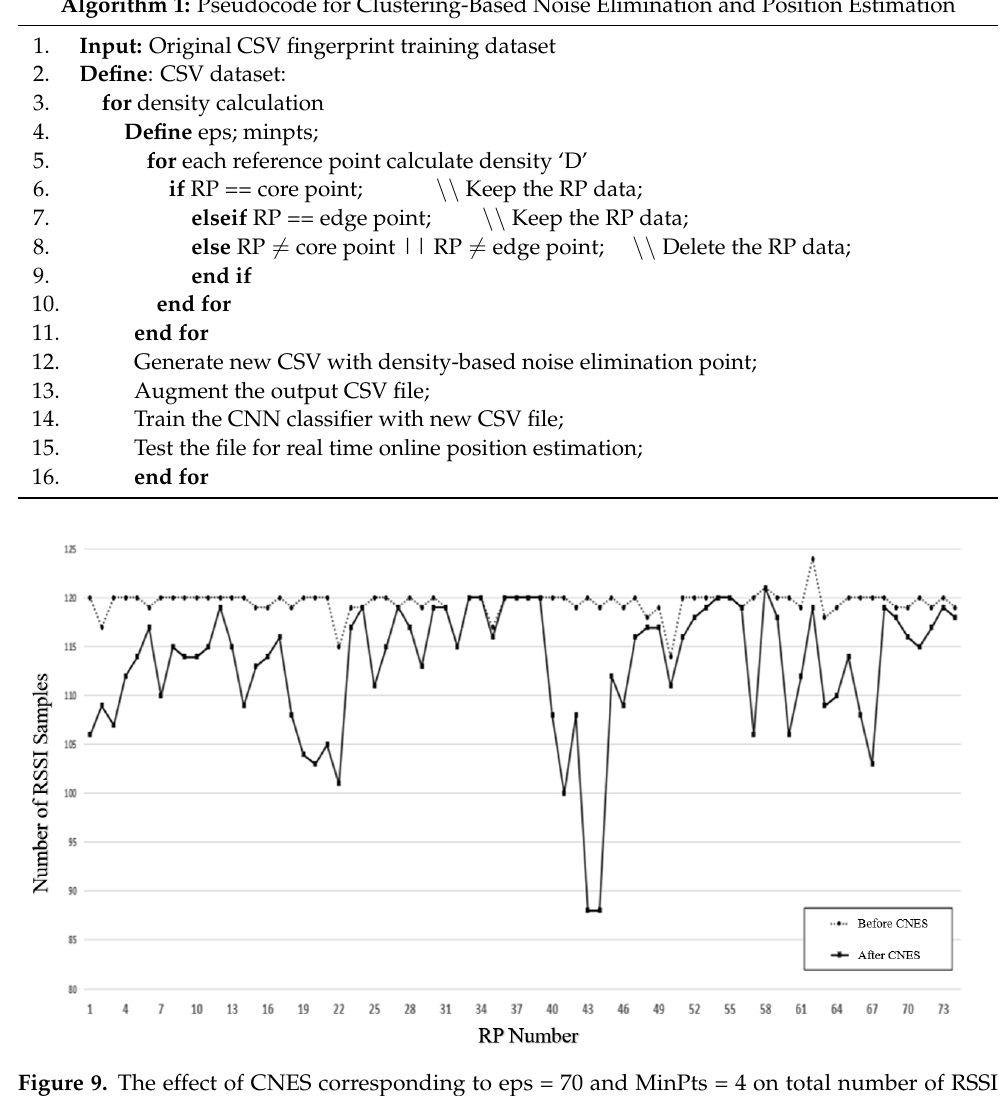
Figure 10. Flow graph for clustering-based noise elimination and position estimation .